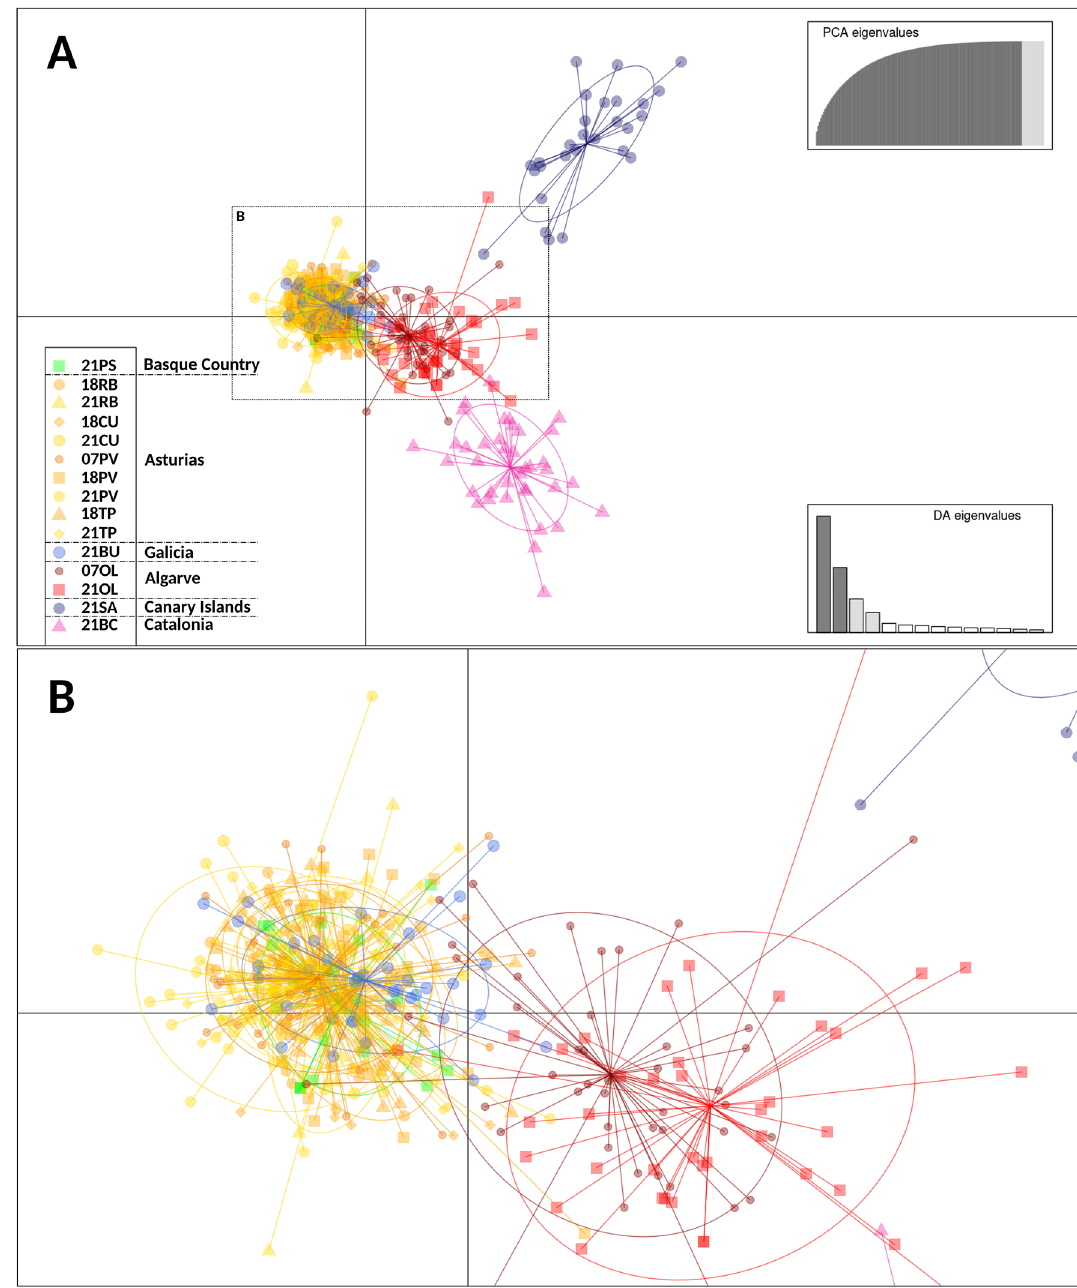
Figure 3. Genetic clustering using Discriminant Analysis of Principal Components (DAPC) of O. vulgaris populations using microsatellites along the Iberian Peninsula and the Canary Islands. ( A ) Global analysis, ( B ) Enlarged detail of localities in the Basque Country, Asturias, Galicia and Portugal. Labels indicate the fishery season (first two digits) and the locality (Pasaia (PS), Ribadesella (RB), Cudillero (CU), Puerto de Vega (PV), Tapia de Casariego (TP), Bueu (BU), Olhão (OL), San Andrés (SA), Barcelona